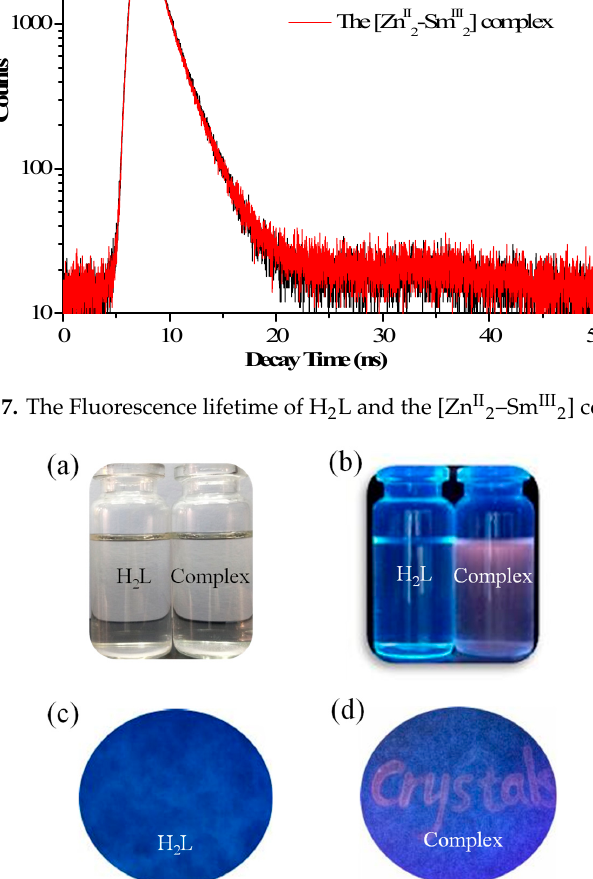
Figure 8. Color contrast of H 2 L and its [Zn II2 –Sm III2 ] complex in ethanol solution under natural light ( a ), Under 365 nm UV light ( b ), Fluorescent imaging with H 2 L labeling ( c ), Fluorescent imaging of the [Zn II2 –Sm III2 ] complex ( d ).